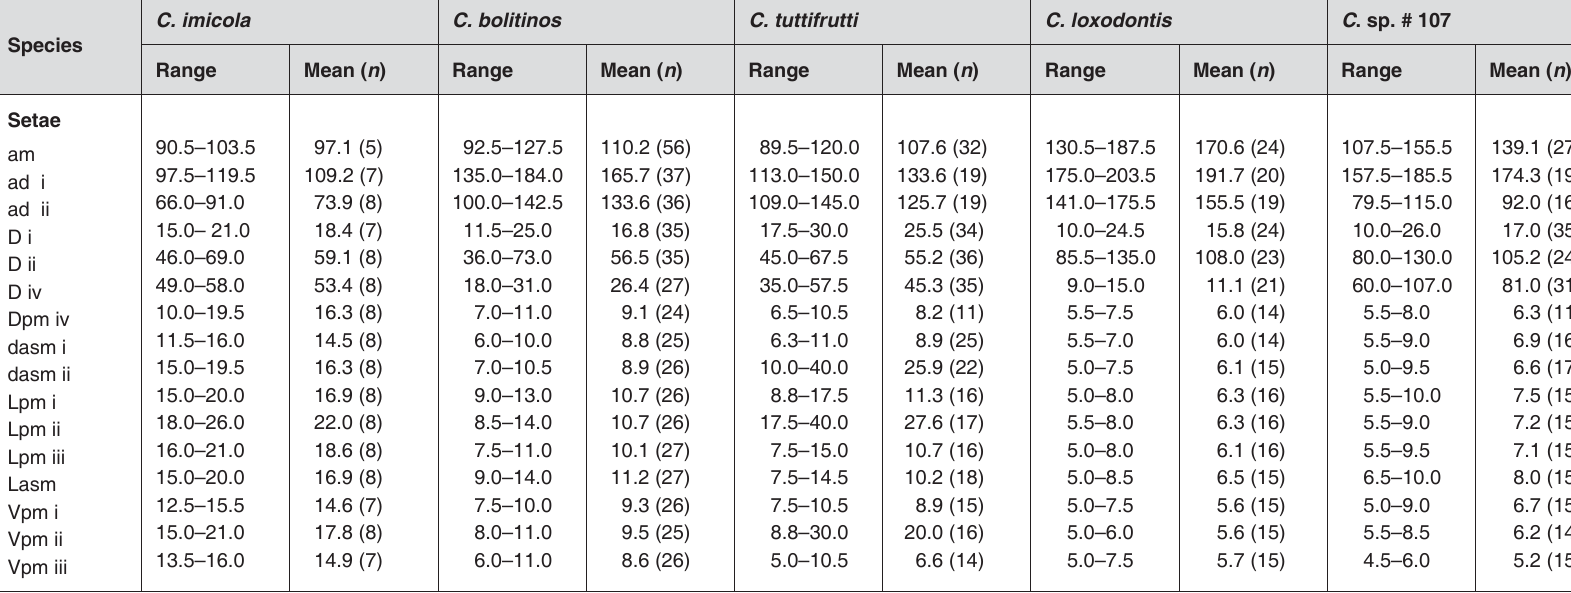
TABLE 5 Lengths ( μ m) of specific cephalothoracic and abdominal setae of the pupae of five species of Culicoides of the Imicola